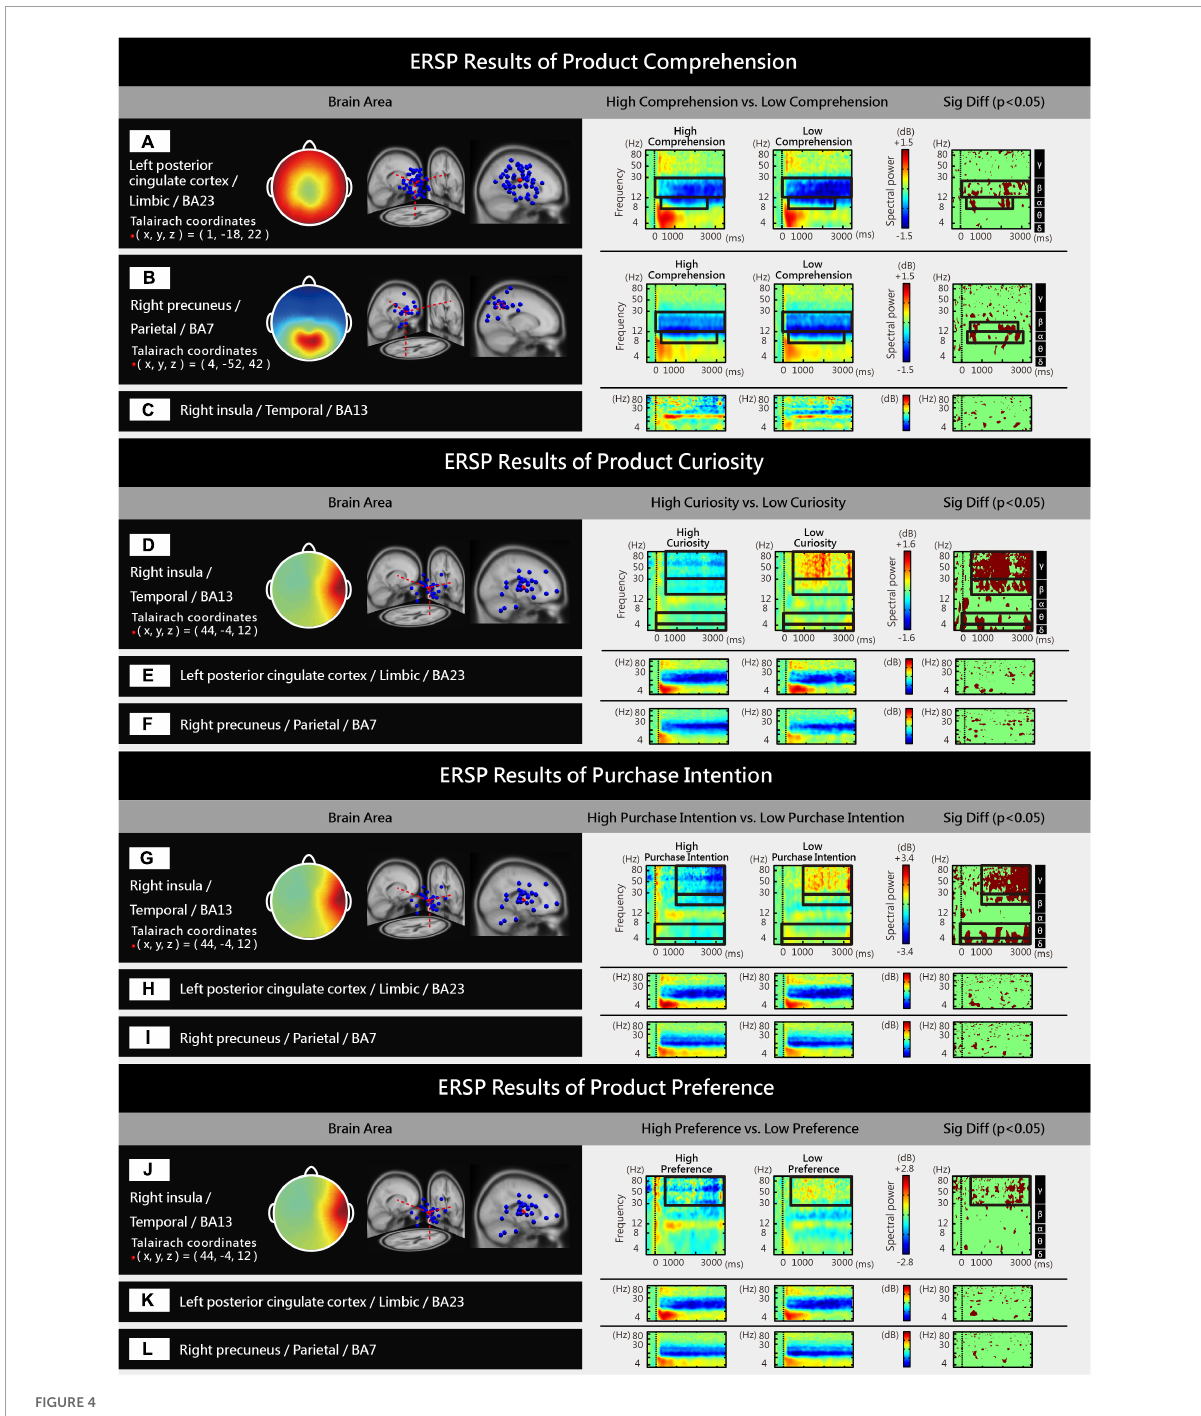
FIGURE4 Significant differences were observed in the ERSPs of different brain areas between high/low levels of internal consumer responses: (A,B) High product comprehension led to higher spectral power in the left PCC and right precuneus than low product comprehension ( p < 0.05). (C) No significant difference was found between high and low product comprehension in the spectral power of the right insula ( p > 0.05). (D) High product curiosity led to lower spectral power in the right insula than low product curiosity ( p < 0.05). (E,F) No significant difference was found between high and low product curiosity in the spectral power of the left PCC and right precuneus ( p > 0.05). (G) High purchase intention led to lower spectral power in the right insula than low purchase intention ( p < 0.05). (H,I) No significant difference was found between high and low purchase intention in the spectral power of the left PCC and right precuneus ( p > 0.05). (J) High product preference led to lower spectral power in the right insula than low product preference ( p < 0.05). (K,L) No significant difference was found between high and low product preference in the spectral power of the left PCC and right precuneus ( p >